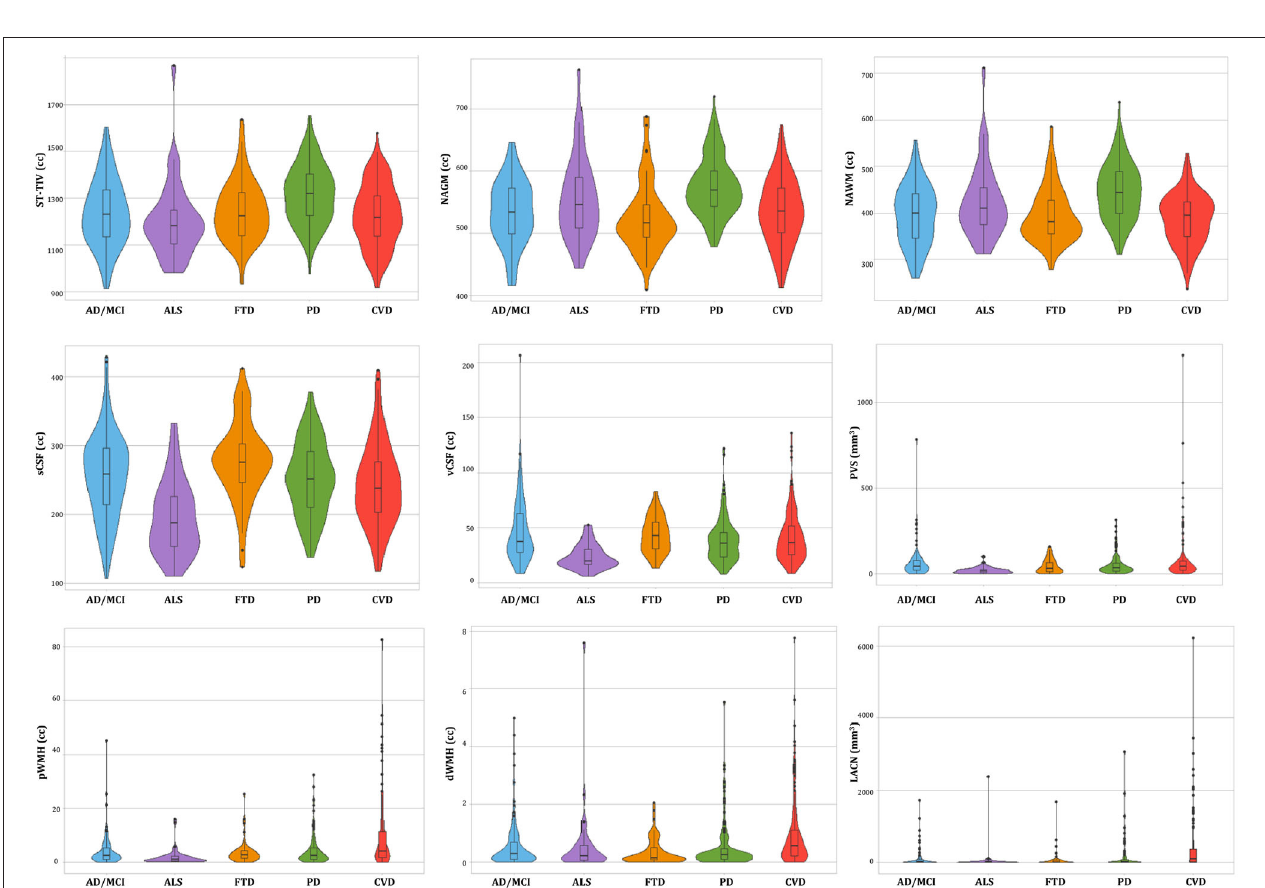
FIGURE 13 | Descriptive violin plots of the ONDRI disease cohorts showing median and interquartile range volumetrics for whole brain supratentorial total intracranial volume (ST-TIV), normal appearing gray matter (NAGM), normal appearing white matter (NAWM), sulcal cerebrospinal fluid (sCSF), ventricular CSF (vCSF), MRI-visible enlarged perivascular space (PVS) volumes, periventricular white matter hyperintensities (pWMH), deep WMH (dWMH), and lacunes (LACN).